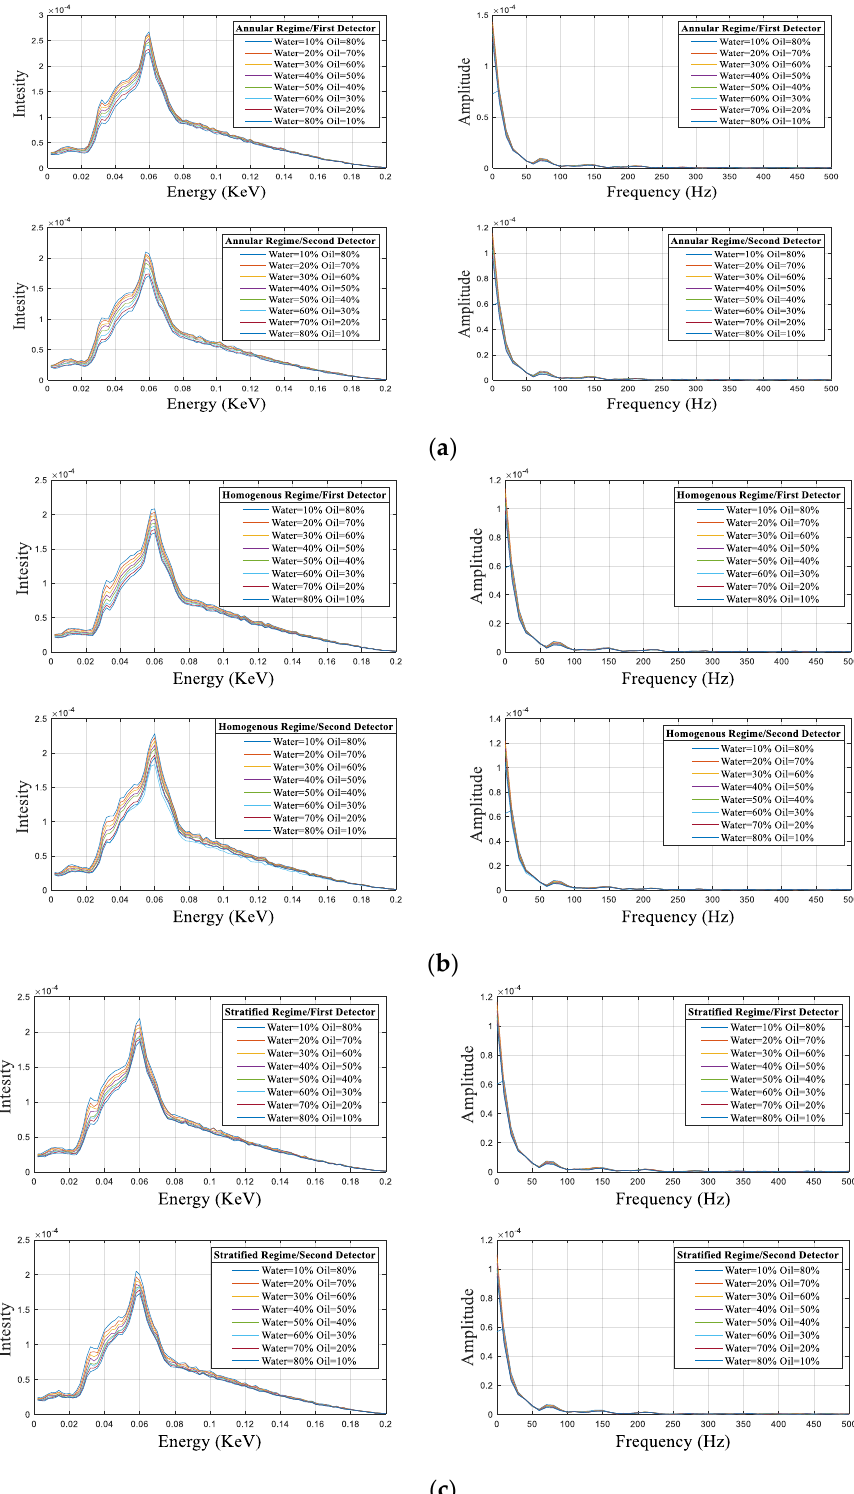
Figure 3. Recorded signals in time domain and converted signals into the frequency domain: ( a ) annular ( b ) homogenous ( c ) stratified flow regimes.